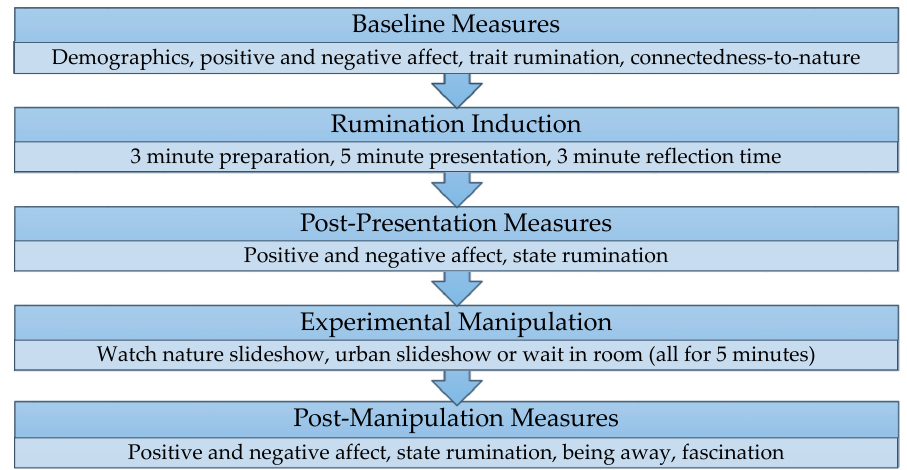
Figure 2. Summary of experimental procedure.